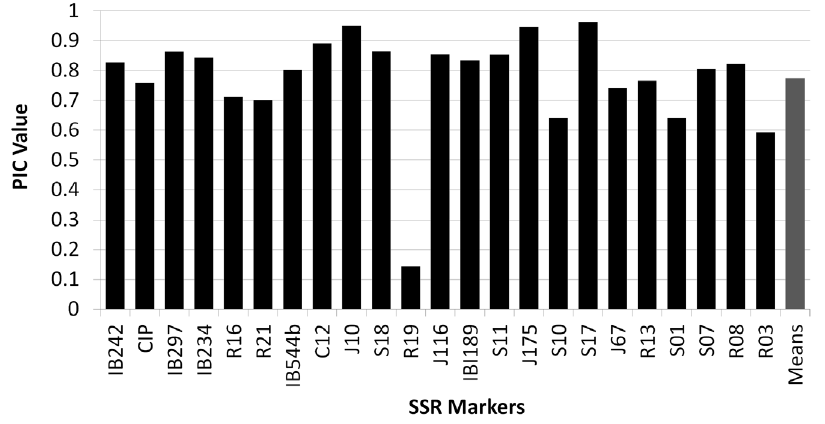
Fig. 2. Polymorphic Index Content (PIC) value of the 23 SSR loci analyzed in 167 accessions of sweet potato ( Ipomoea batatas ).